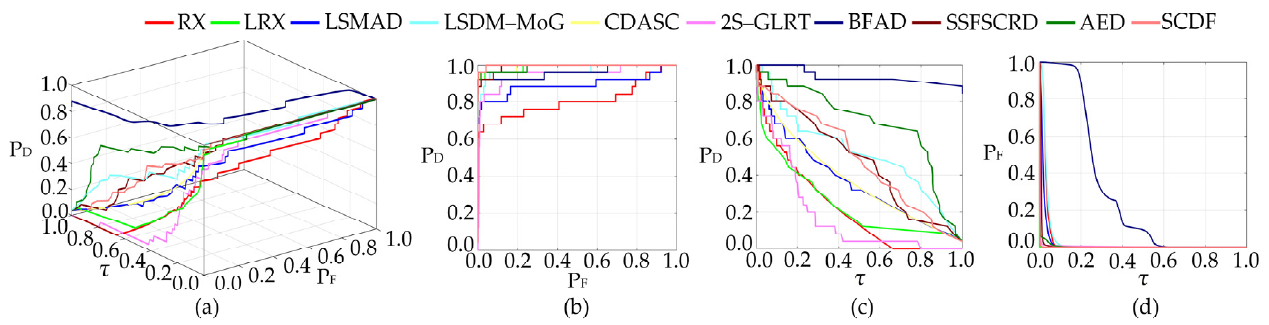
synthetic dataset: ( a ) 3D ROC curve; ( b ) corresponding 2D ROC curve (P D , P F ); ( c ) corresponding 2D